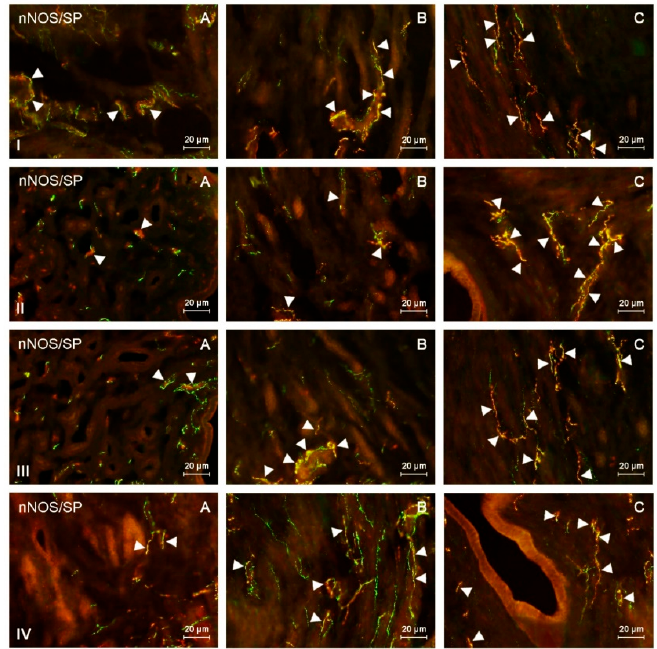
Figure 3. nNOS-positive nerves (nNOS + green) immunoreactive to substance P (SP) (red) in the: (I) muscular layer of the corpus, (II) mucosal layer of the corpus, (III) muscular layer of the horns, (IV) mucosal layer of the horns of the uterine body of control animals ( A ) and pigs treated with low ( B ) and high ( C ) dose of bisphenol A. Nerves simultaneously immunoreactive to nNOS and SP (yellow) are indicated with arrowheads.